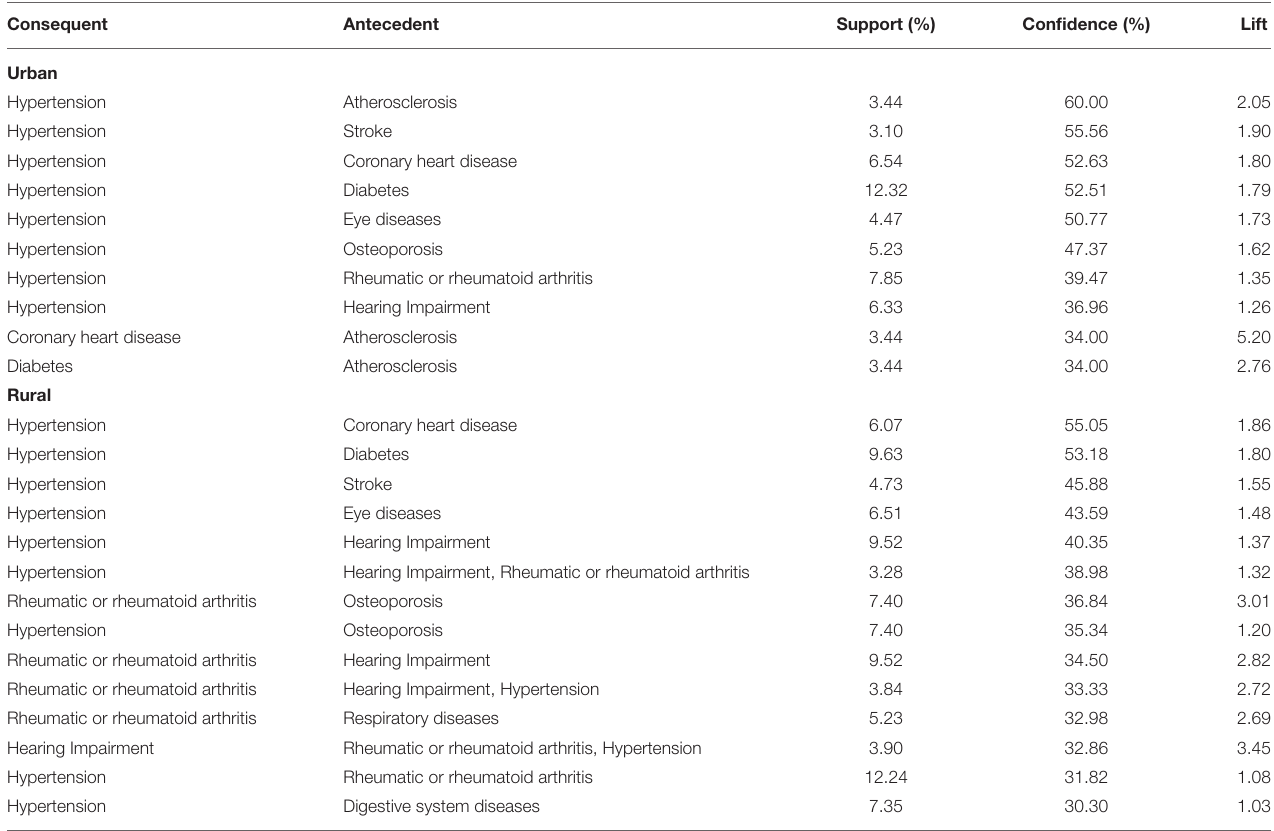
TABLE 3 | Analysis results of urban–rural differences in association rules for multimorbidity. Consequent Antecedent Support (%) Confidence (%)